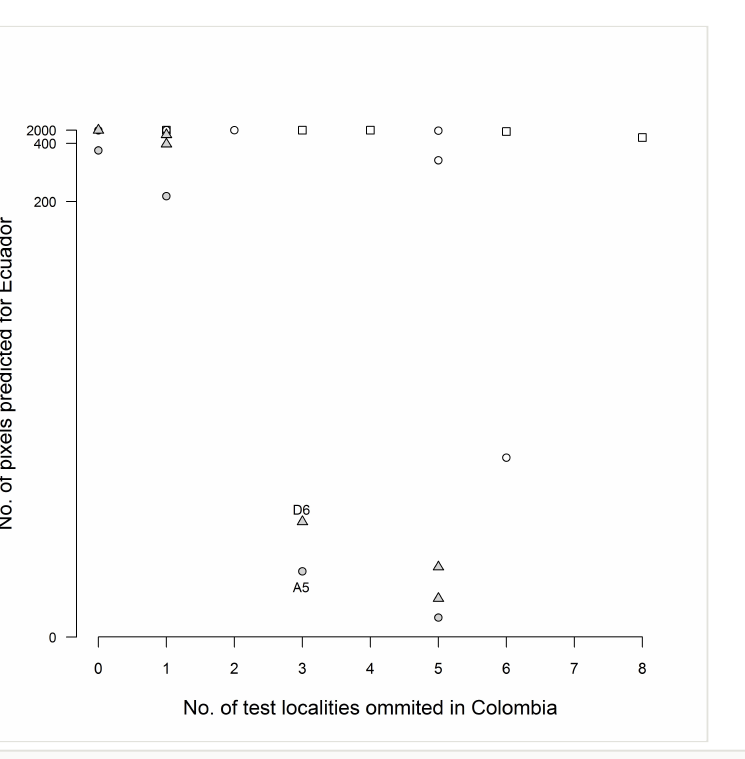
Number of Lesbia nuna test localities omitted in Colombia, contrasted against the number of pixels predicted for Ecuador. ● ALL models, ▲ C+S , ○ CON, □ C+G, combined with seven thresholds. A5 refers to ALL model + Equal training sensitivity and speci fi city logistic threshold and D6 refers to C+S + Maximum training sensitivity plus speci fi city logistic